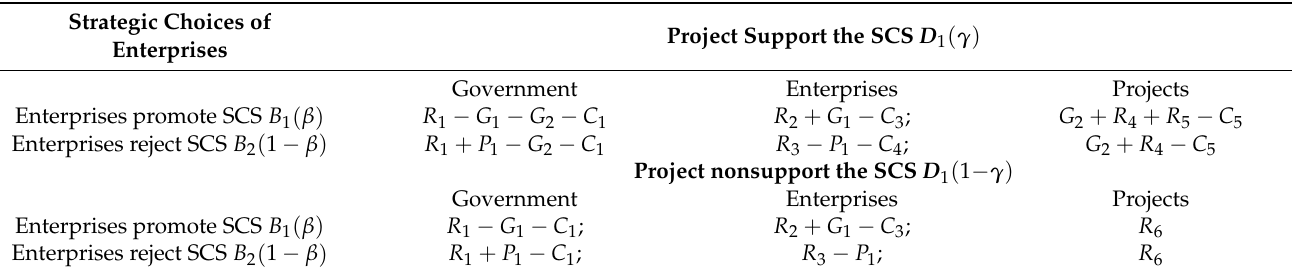
Table 2. Payment matrix under government selective intervention strategy.